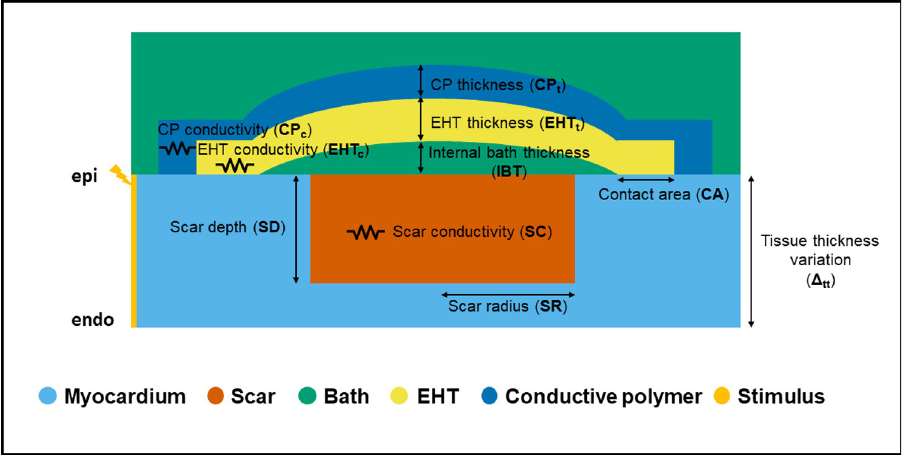
Fig 1. Schematic representation of our thin 3D tissue slab model along with the 10 design input parameters considered: Scar radius (SR), Scar depth (SD), Scar conductivity (SC), Engineered heart tissue thickness (EHT t ), Engineered heart tissue conductivity (EHT c ), Contact area (CA), Conductive polymer thickness (CP t ), Conductive polymer conductivity (CP c ), Internal bath thickness (IBT), Tissue thickness variation ( Δ tt